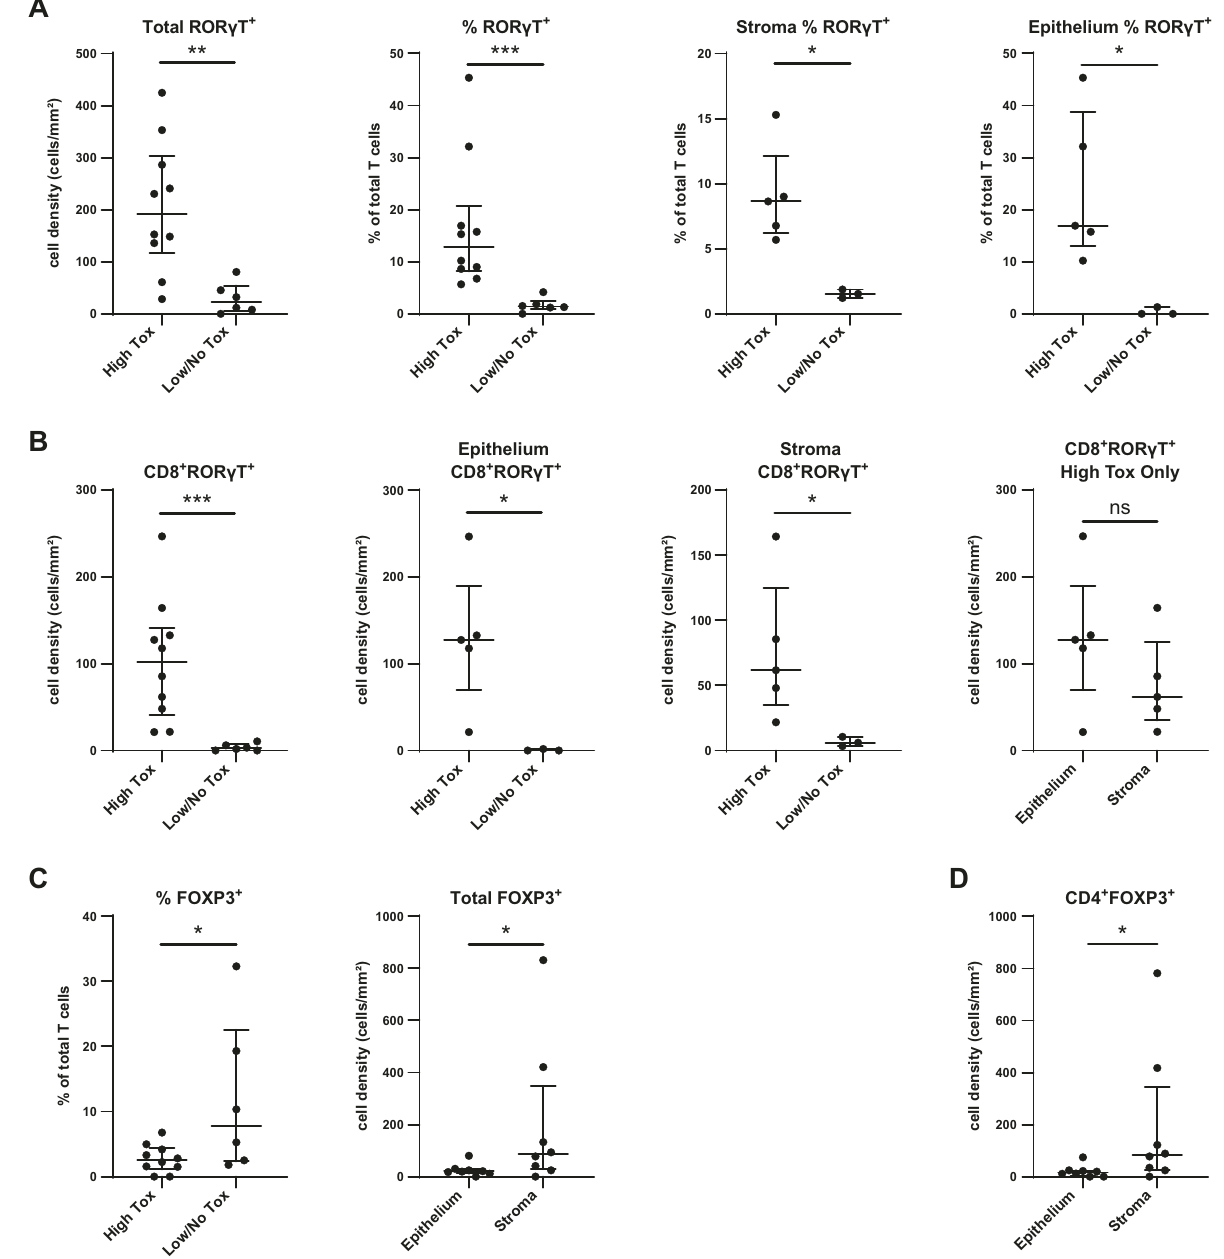
Fig. 6 Multiplex immuno fl uorescence demonstrates in fi ltration by CD8 + ROR γ T + T cells in GI biopsies from patients with high toxicity. A ROR γ T + cells measured by cell density or % of total T cells, comparing patients with high GI toxicity to low/no toxicity. In fi ltration is seen in both stroma and epithelium. B CD8 + ROR γ T + in fi ltration in patients with high GI toxicity, seen in both stroma and epithelium. C FOXP3 + cells measured by % of total T cells or cell density, between patients with high GI toxicity or low/no toxicity. D CD4 + FOXP3 + cells measured by cell density between epithelium and stroma regions. A – D Patients with a liver biopsy are excluded from these graphs. ns = not signi fi cant; * p ≤ 0.05; ** p ≤ 0.01; *** p ≤ CD4 and CD8 T cell in fi ltration but did not show signi fi cance for ROR γ T + cells (Supplementary Fig. 8).